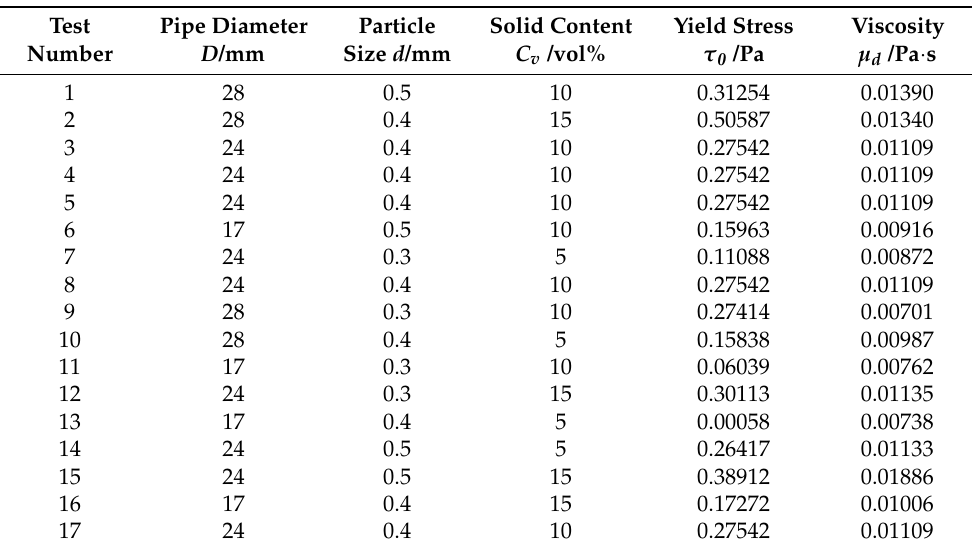
Table 4. Test design